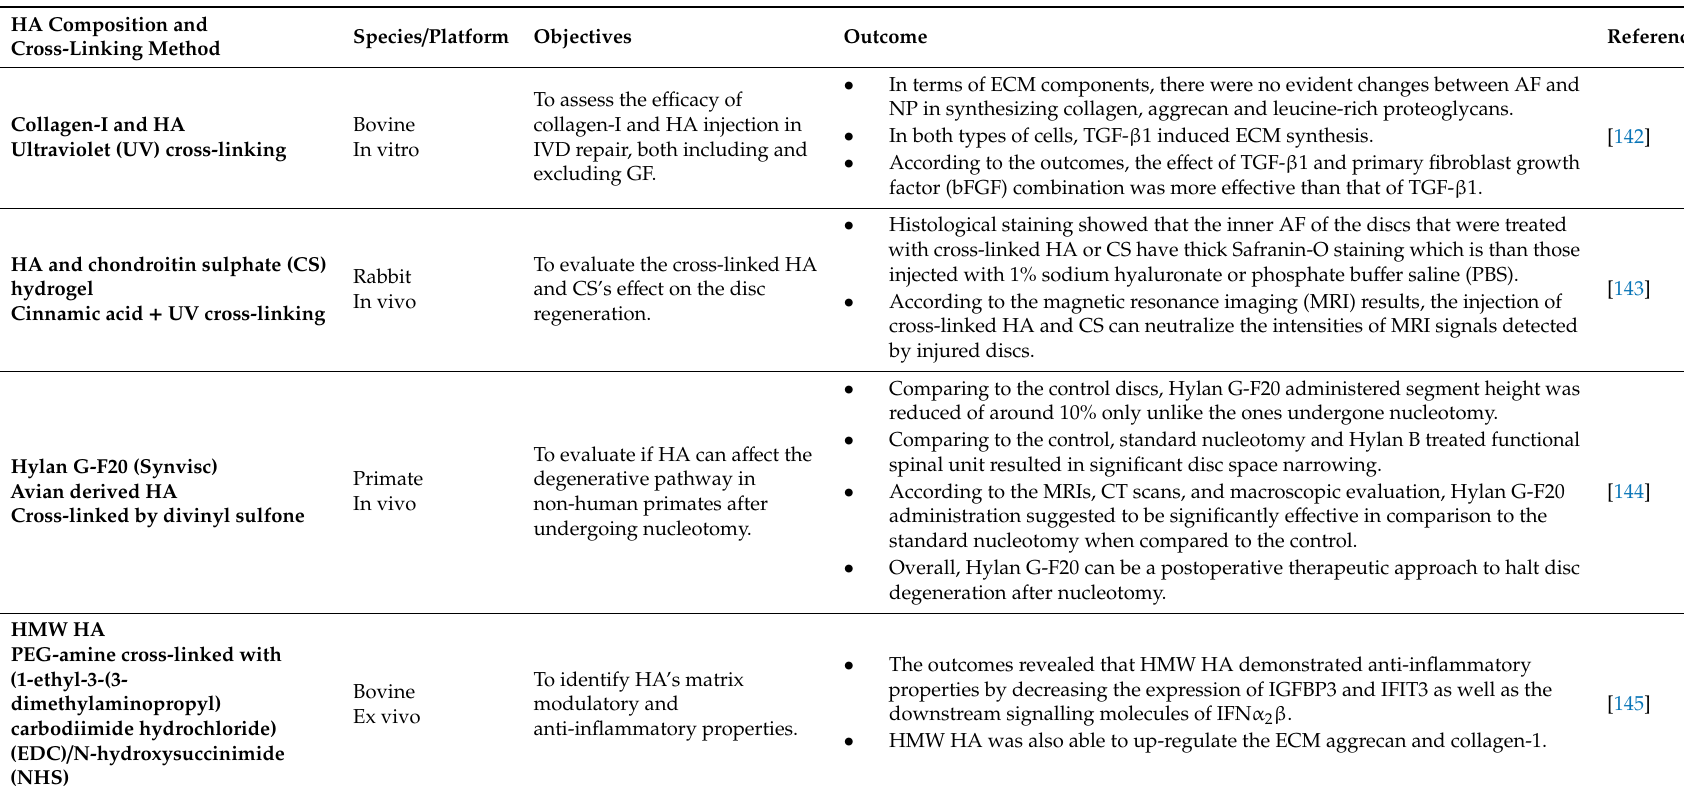
Table 2. Di ff erent hyaluronic acid compositions evaluated in preclinical and clinical trials for IVD